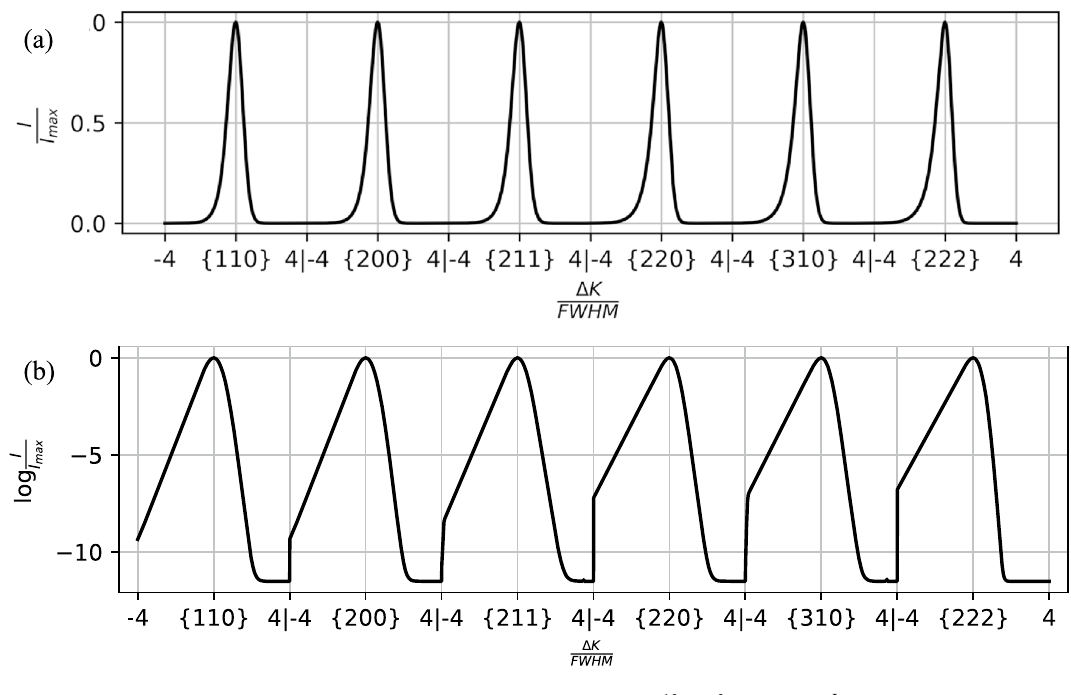
L 2 10 12 m ) from the ǫ -based synthetic database − ×